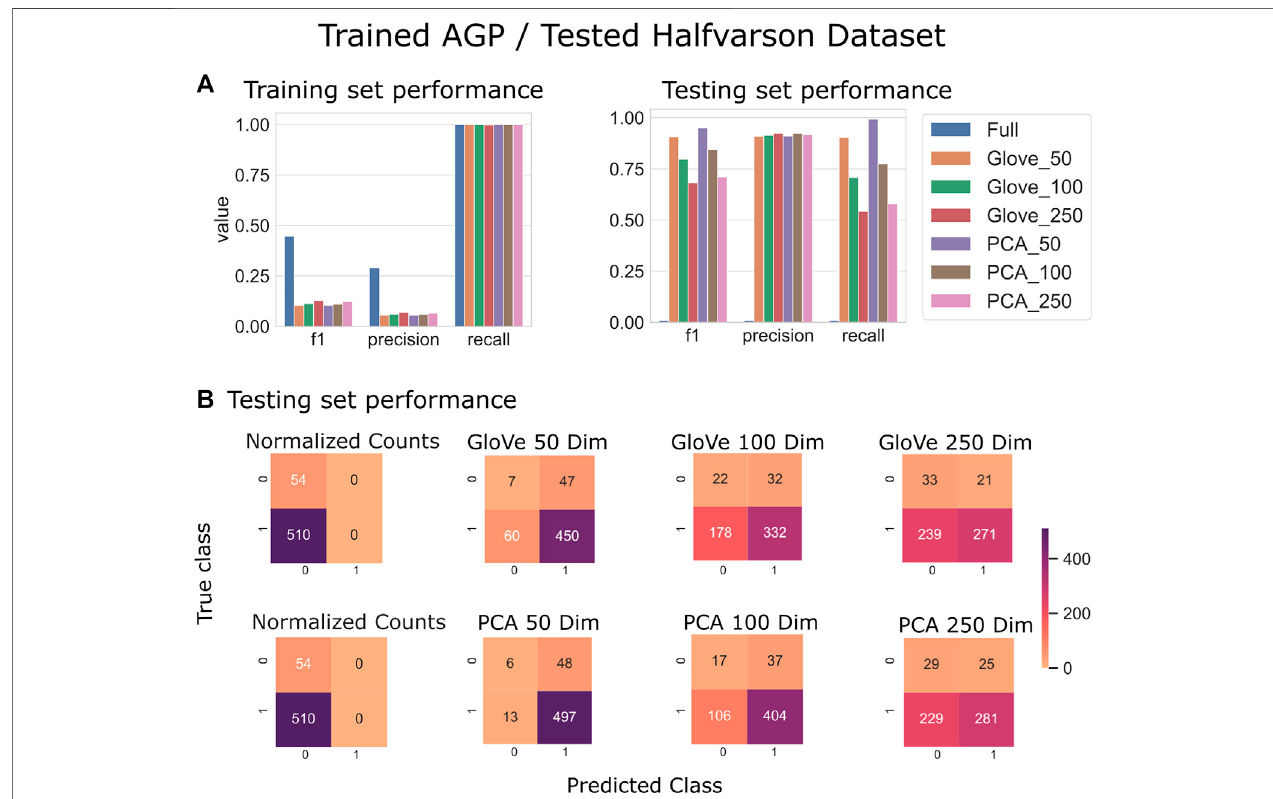
FIGURE 2 | Predicting IBD: Model trained on AGP data and tested on Halfvarson data. (A) : Models built using GloVe embedded data, PCA embedded data (50, 100, or 250 dimensions), or normalized ASV counts performance on training and testing sets. (B) : Confusion matrices showing the distribution of correct to predicted classes on the testing